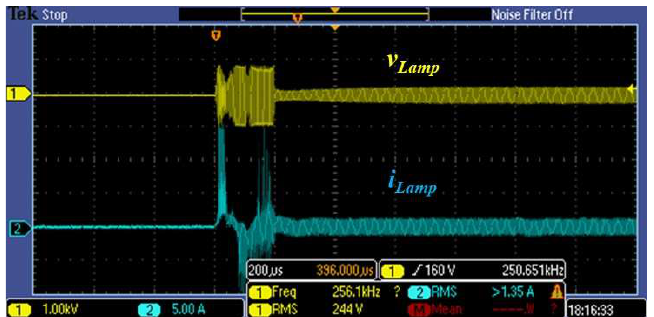
Figure 14. EFL Lamp voltage ( v lamp ) and current ( i lamp ) during the commercial lamp ignition transient.